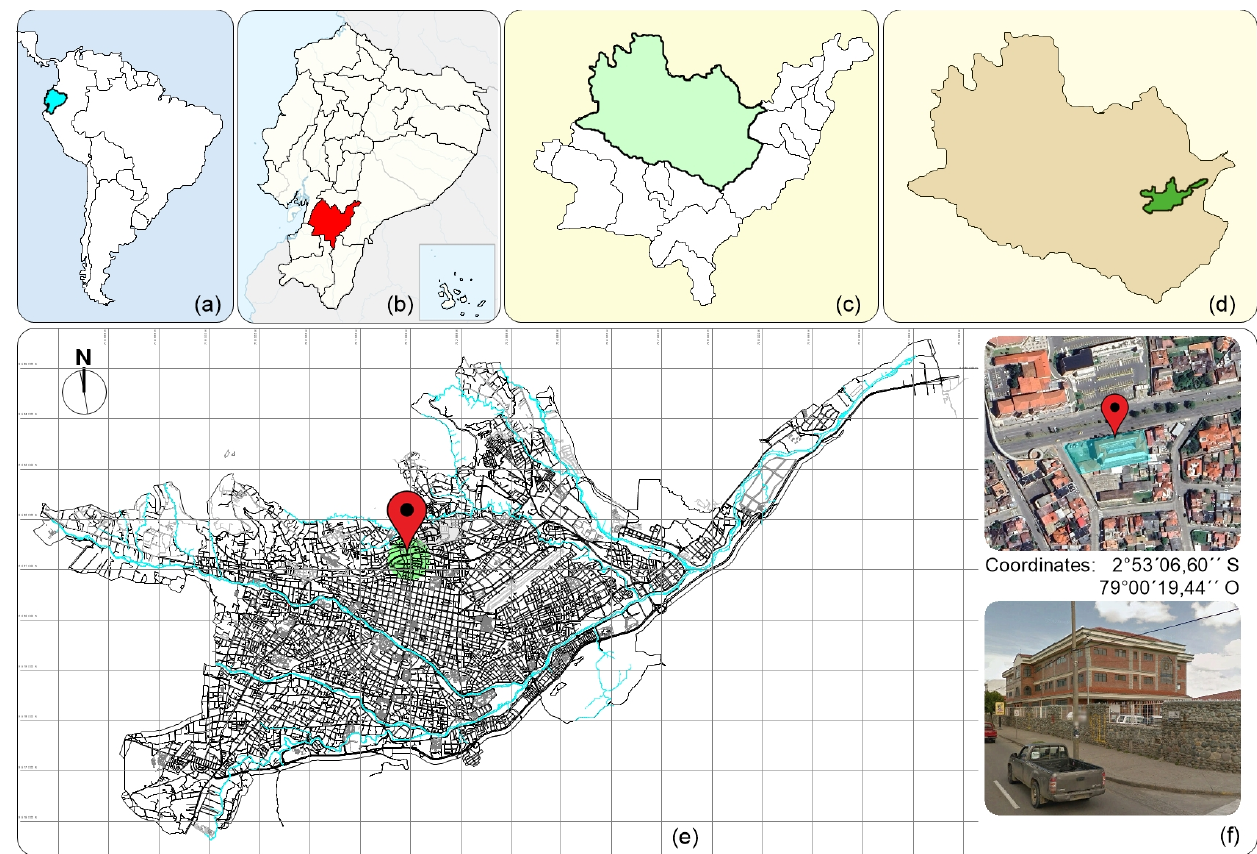
Figure 6. Location of the study area, Catholic University of Cuenca Headquarters. ( a ) Location of Ecuador in South America. ( b ) Province of Azuay in Ecuador. ( c ) Cuenca in the province of Azuay. ( d ) Urban area of the city of Cuenca. ( e ) Study area within the city of Cuenca. ( f ) Faculty of Architecture of the Catholic University of Cuenca.